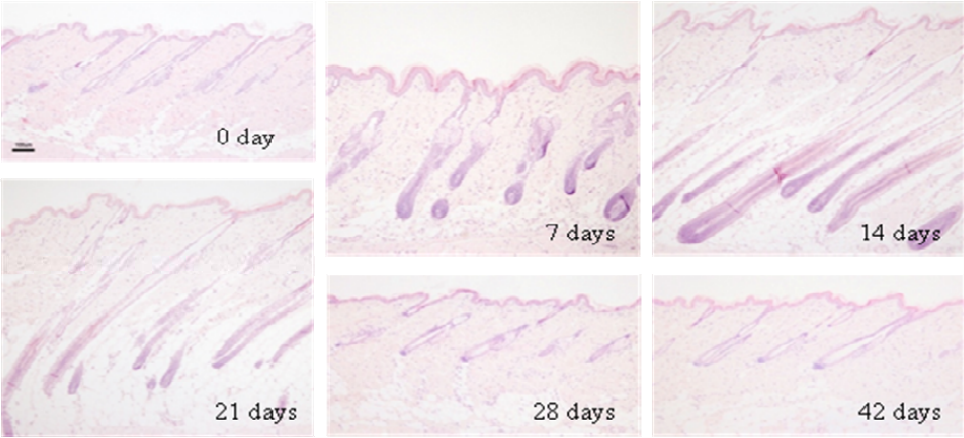
Figure 1. Changes in histology of dorsal skin of male Mini rats after depilation of telogen- phase hairs at 10 weeks old. HE stain, Bar = 100 μ m.